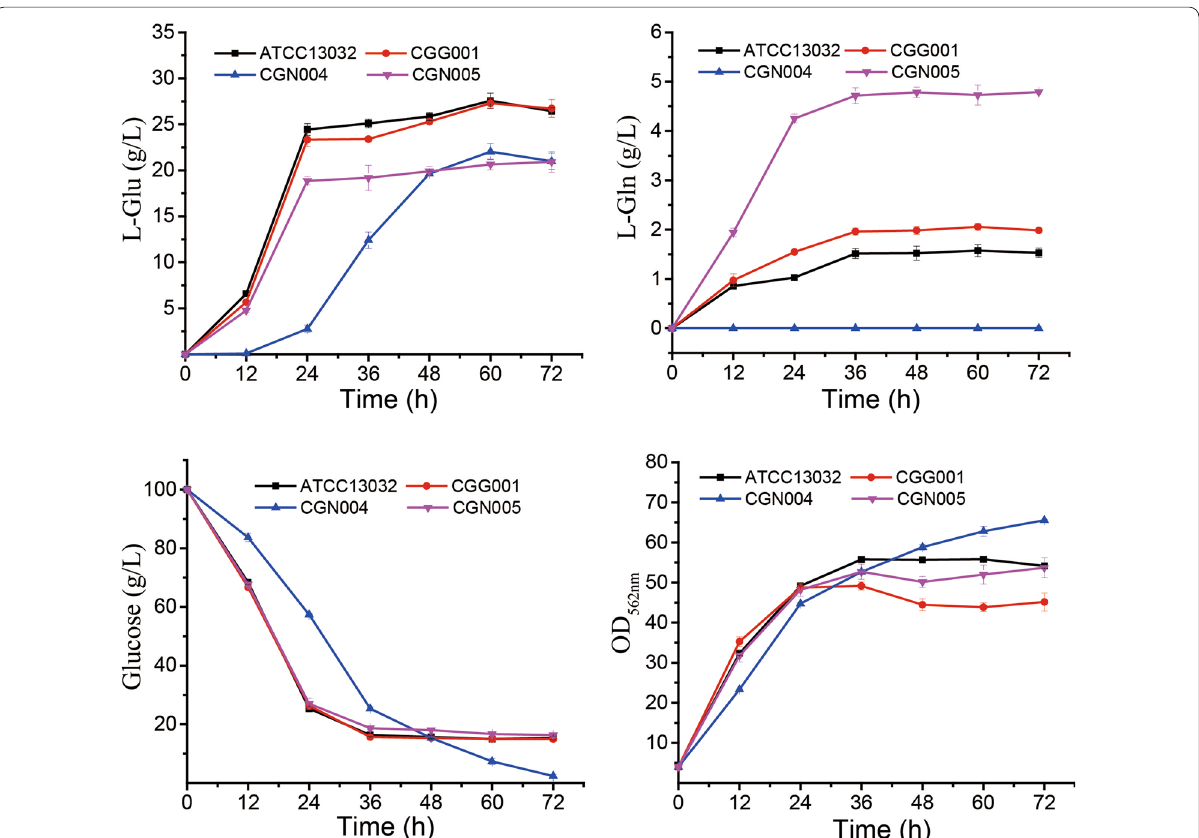
Fig. 3 The fermentation results of the strains CGG001, CGN004 and CGN005. C. glutamicum ATCC 13032 was used as control. l -Glu: l -Glutamic acid; l -Gln: l -Glutamine. The results showed the concentration of l -Glu and l -Gln in fermentation broths. Meanwhile, the cell density (OD 562nm ) and the glucose concentration also been showed in the results. Data was shown as mean statistics, α =